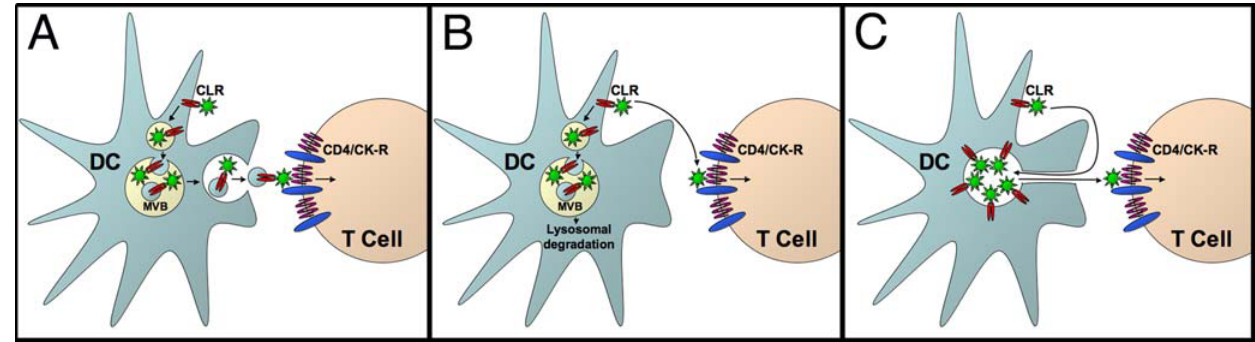
Figure 9. Models of trans -infection. (A) MVB/exosomal transfer. HIV is endocytosed and concentrated in a non-degradative late endosome/ multivesicular body (MVB). The MVB is subsequently transported to the T cell interface, where it fuses to the DC plasma membrane and delivers HIV by exocytosis. (B) Surface transfer. Only surface-bound HIV is able to infect T cells. Internalized HIV is degraded following lysosomal maturation. (C) Pocket transfer. HIV is concentrated and internalized in a non-endosomal compartment that remains contiguous with the plasma membrane. HIV remains accessible to the extracellular milieu, and individual virions are delivered back to the DC surface prior to transmission.